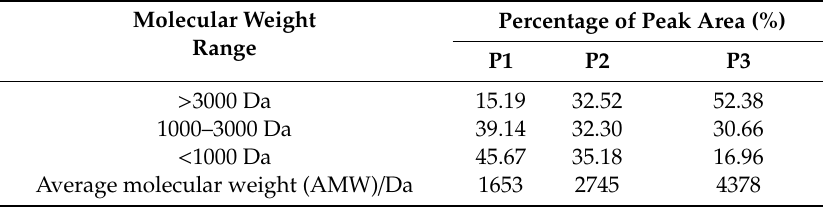
Table 1. Molecular weight distribution of peptide